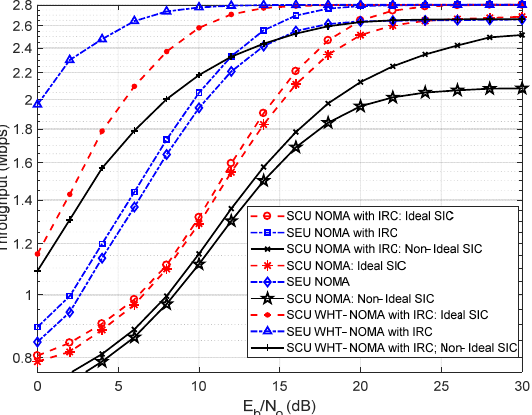
Figure 20. Throughput performance with IRC using QAM modulation; NOMA vs. WHT–NOMA, power allocation: SCU = 0.2 and SEU = 0.8.